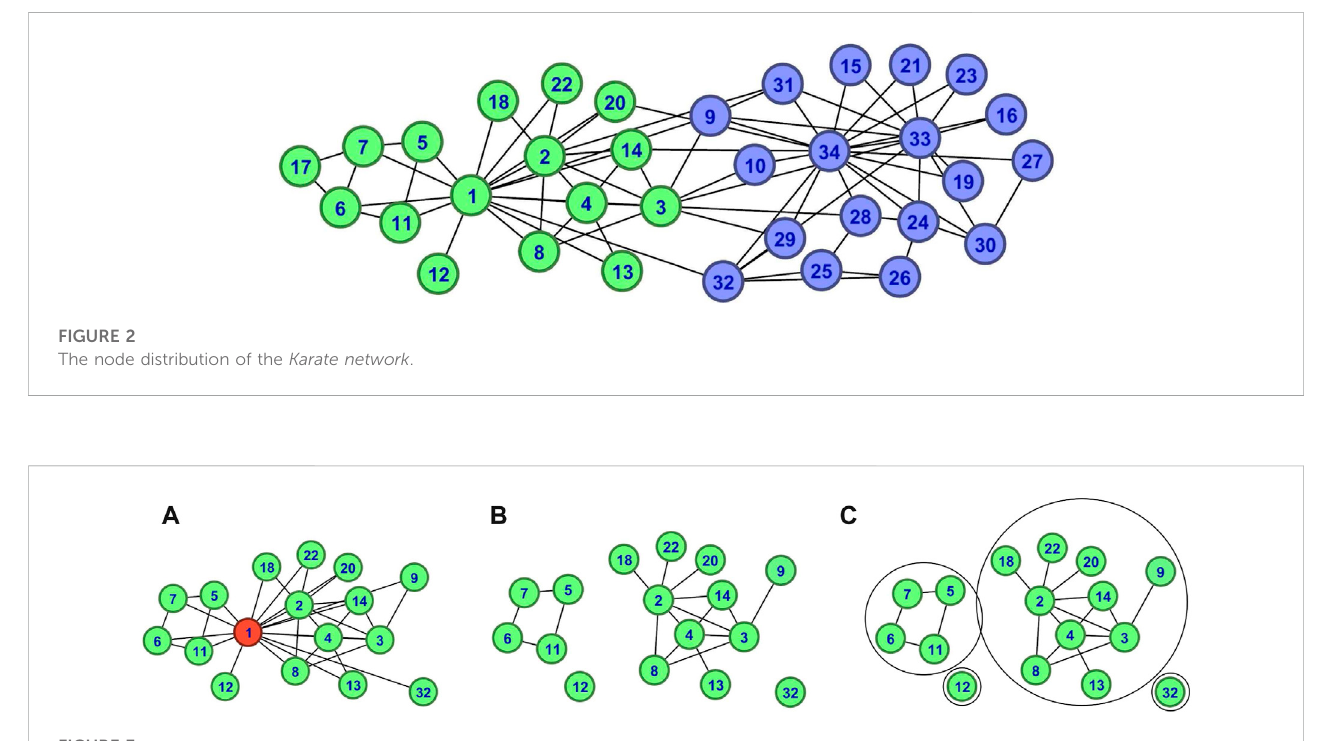
FIGURE 3 An example of exploring the potential community of node v 1 . (A) The distribution of node v 1 and its neighbors. (B) Remove v 1 and its links between its neighbors. (C) Potential communities of v 1